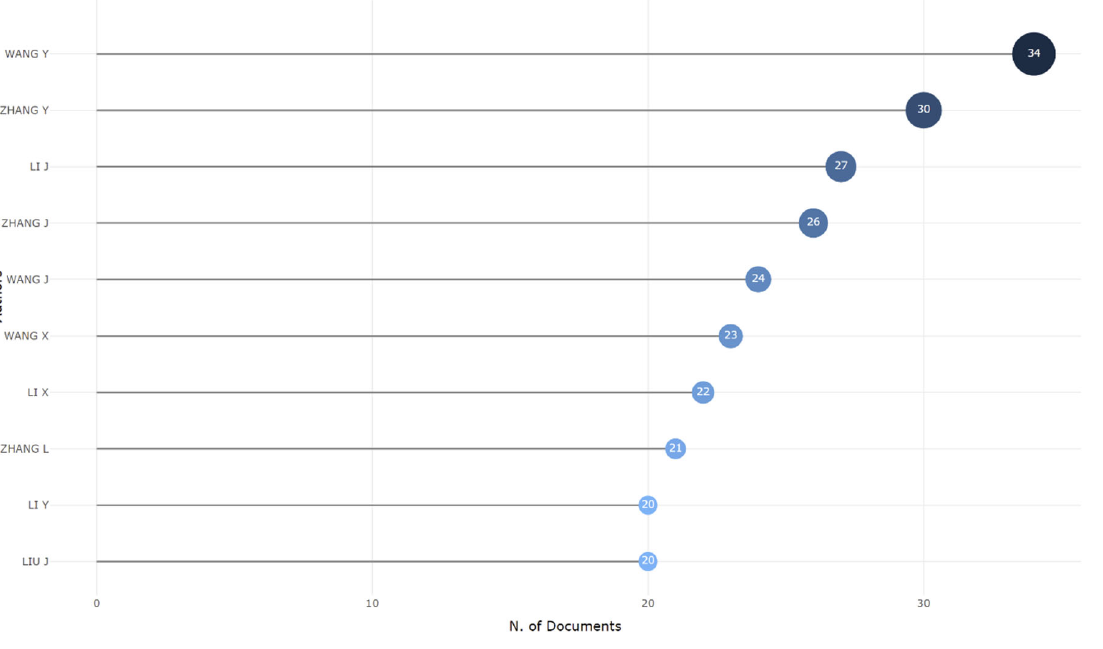
Table 2. Corresponding authors’ countries. Country